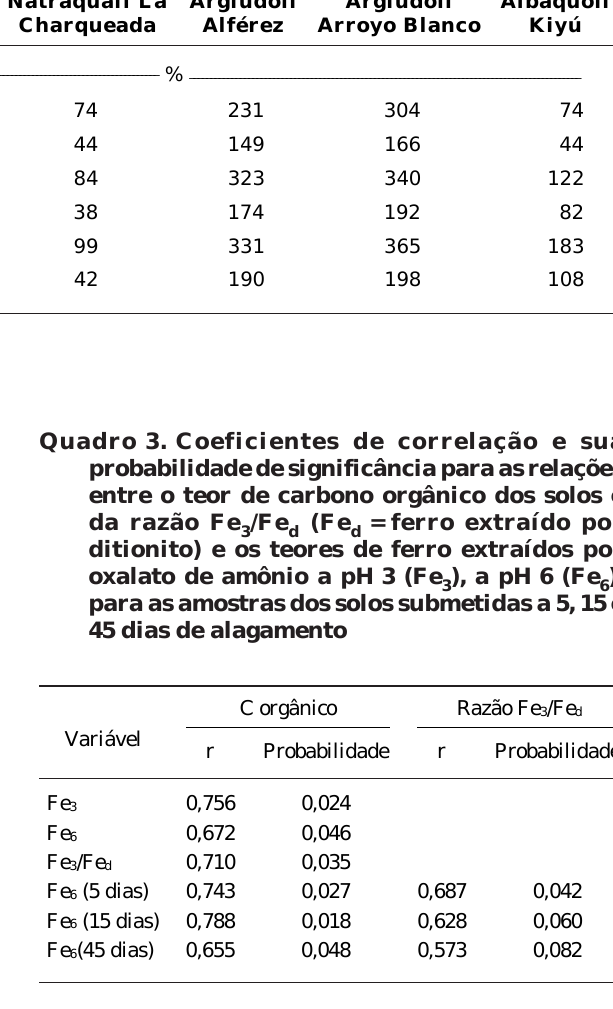
Figura 1. Evolução do pH em água dos seis solos durante o